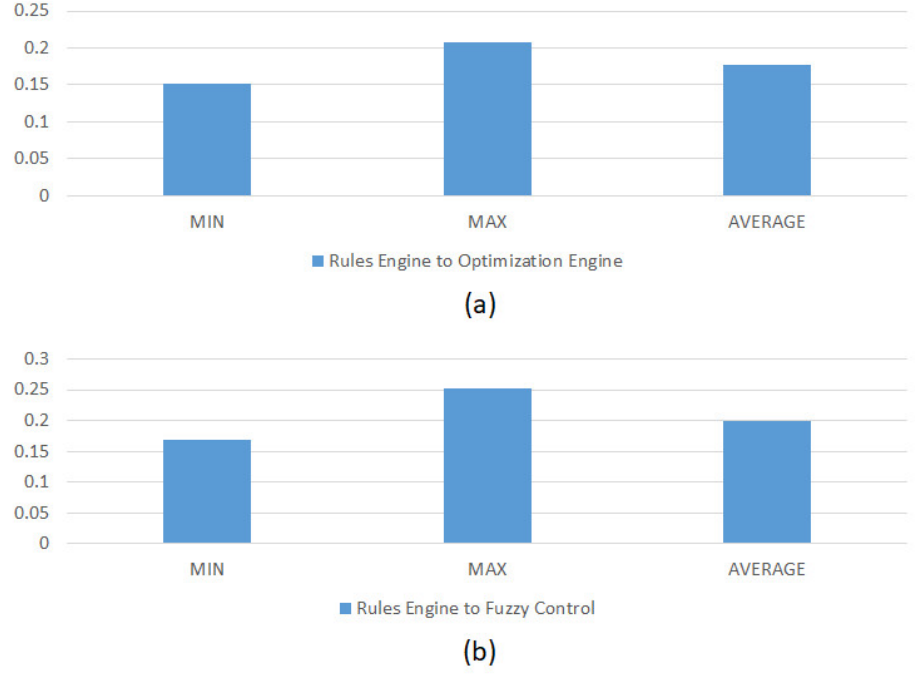
Figure 18. Proposed Microservices Memory Usage on Raspberry Pi 3. ( a ) Optimization Engine. ( b ) Fuzzy